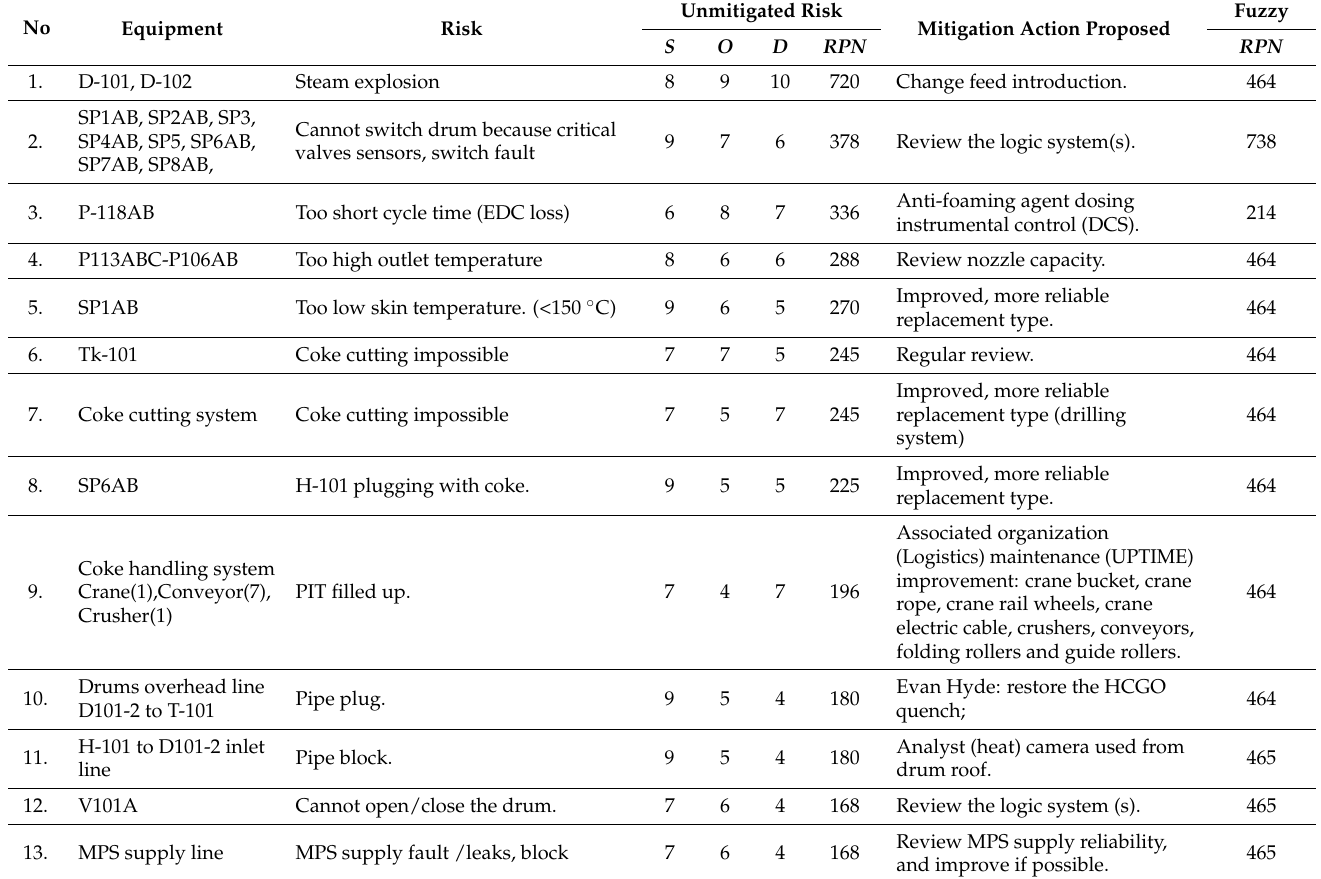
Table A3. Example of FMEA for the drum system of